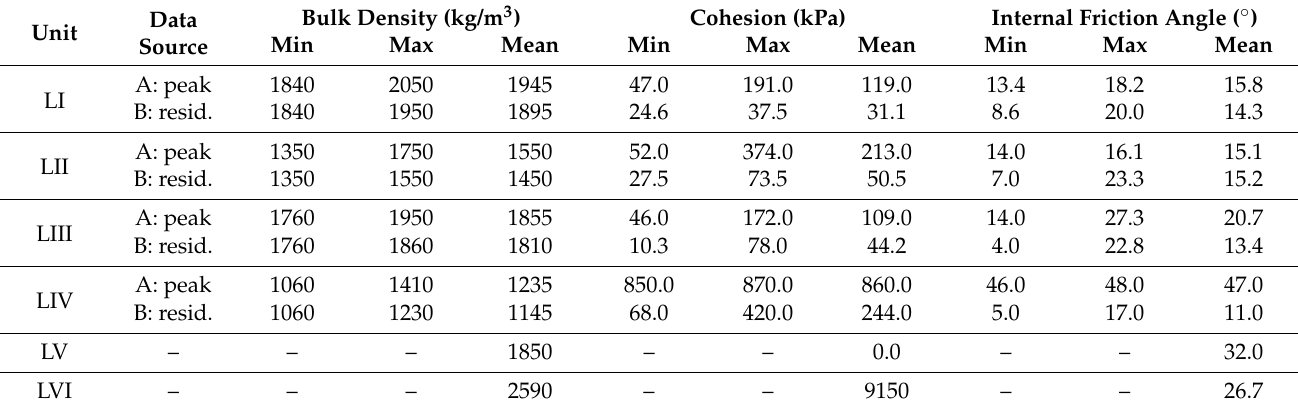
Table 2. Parameters of the lithological units adopted for the sensitivity